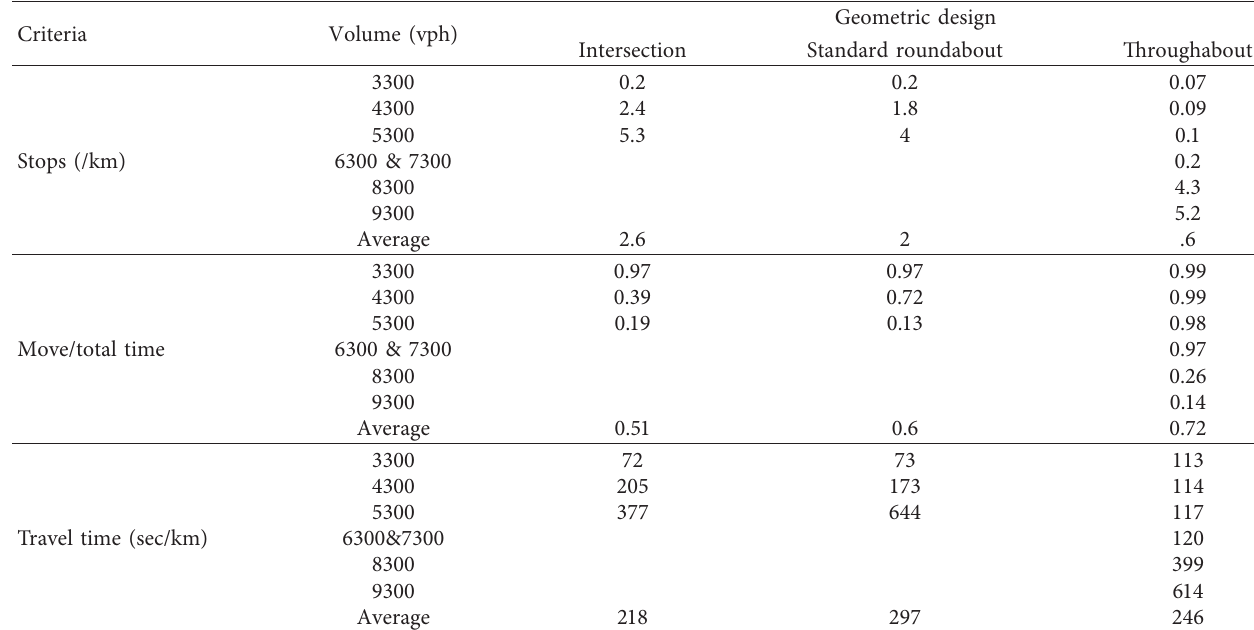
Table 6: Travel time and movement smoothness indexes in the unsignalized